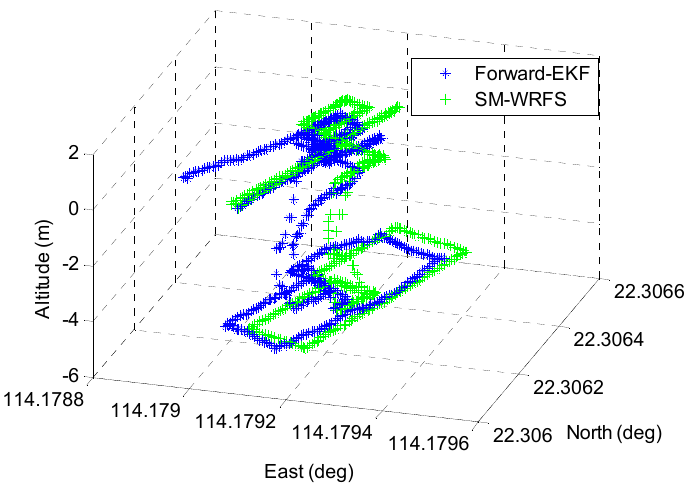
Figure 12. Performance of Proposed SM-WRFS.